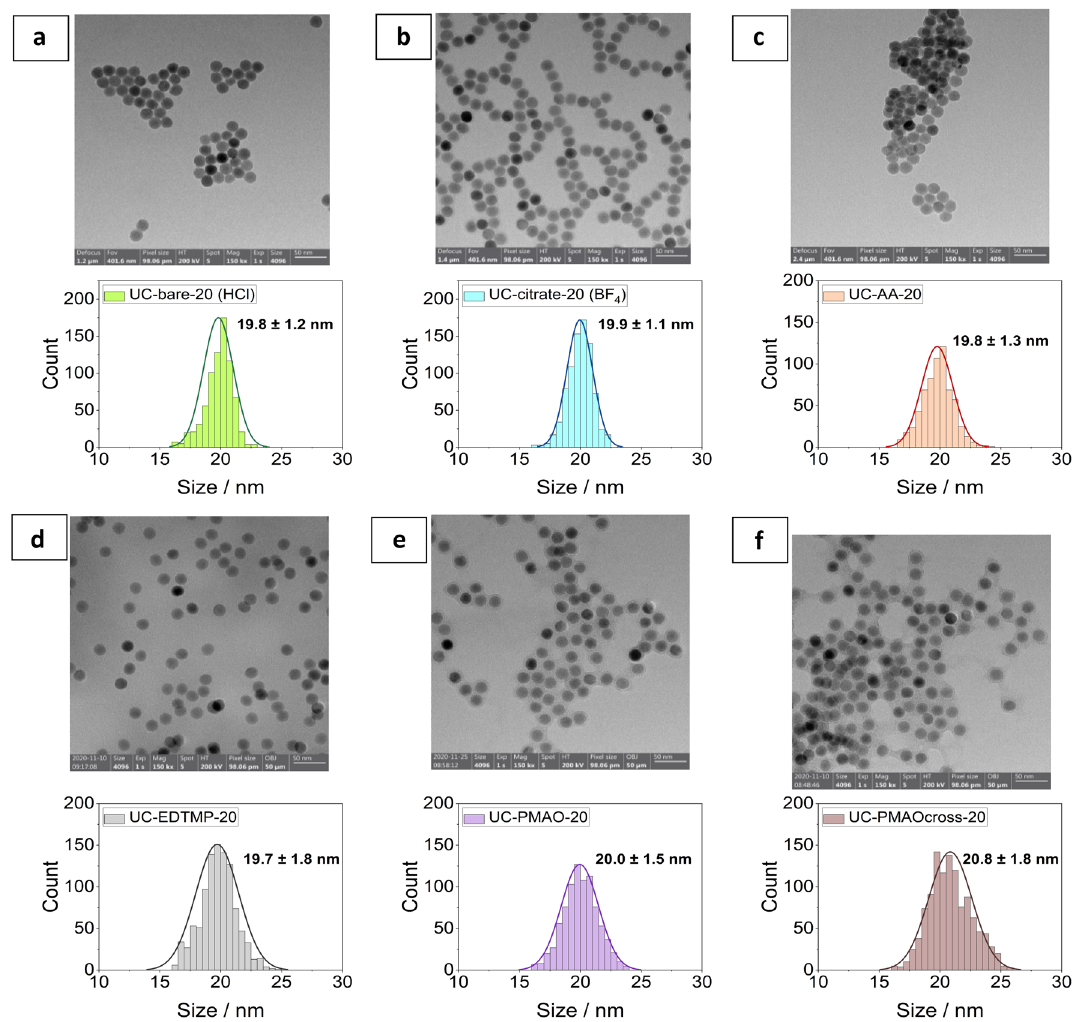
Figure 1. Transmission electron microscopy (TEM) images of UCNP with different surface coatings. ( a ) UC-bare-20 (HCl); ( b ) UC-citrate-20 (BF 4 ); ( c ) UC-AA-20; ( d ) UC-EDTMP-20; ( e ) UC-PMAO-20; ( f )